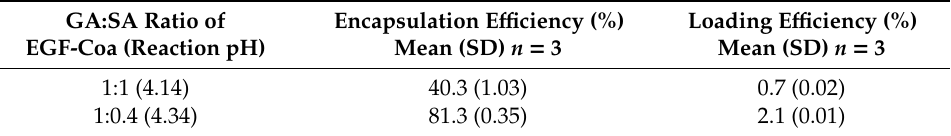
Table 4. Quantitative encapsulation efficiency and loading efficiency of EGF-coacervates. GA:SA Ratio